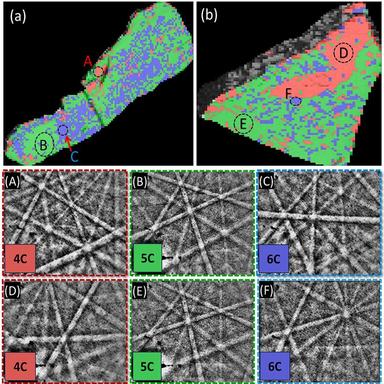
The EBSD phase mapping of the concentrate sample for two different grains (a) and (b). Panels (A) to (F) display the Kikuchi patterns corresponding to the sites A to F on grains (a) and (b).